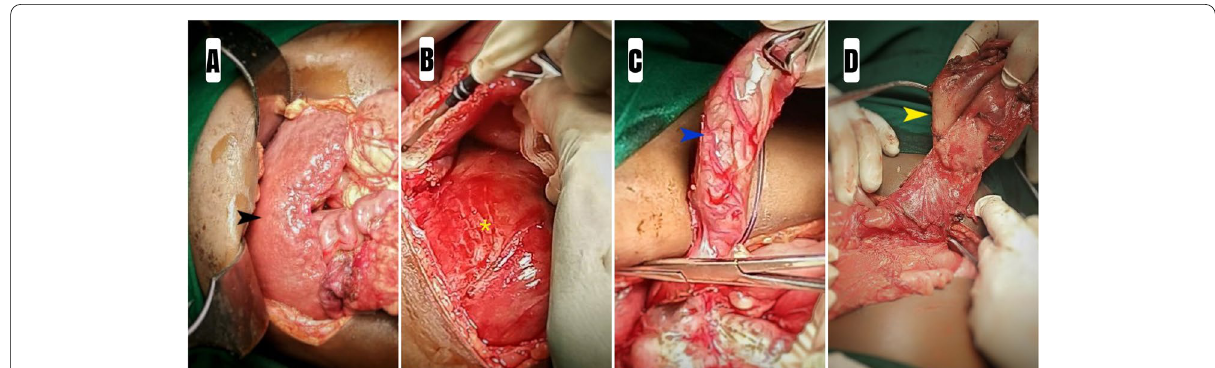
Fig. 3 A – D : Intraoperative images. ( A ) Black arrowhead showing a cirrhotic liver. ( B ) Yellow asterisk showing the extrahepatic (CBD) cyst before mobilization. ( C ) Blue arrowhead showing the mobilized GB. ( D ) Yellow arrowhead showing the mobilized choledochal cyst